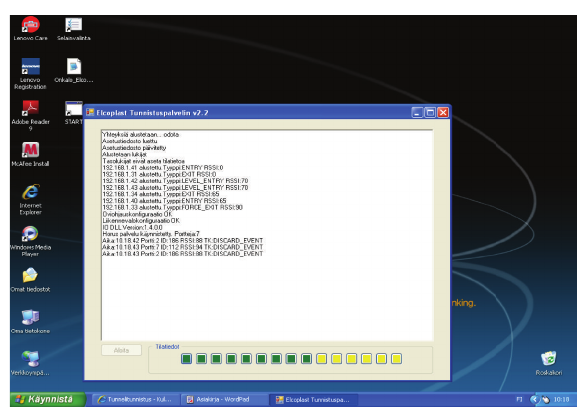
Figure 13: The HorusWindow application logic program.